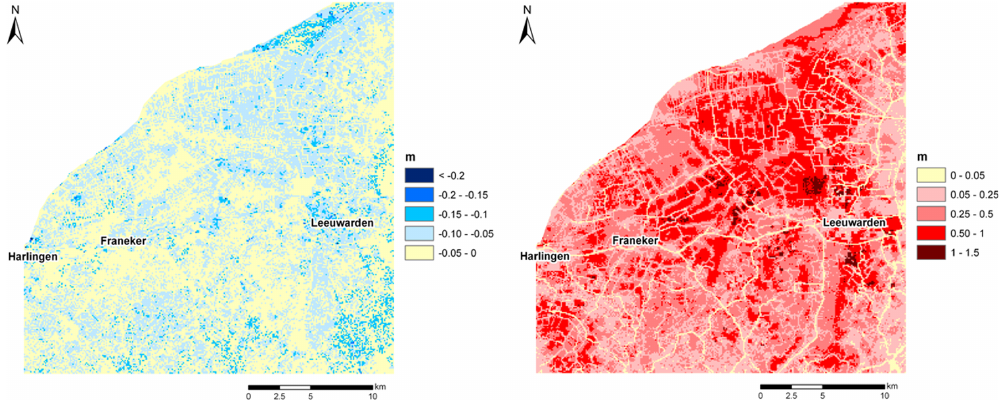
Fig. 21. Groundwater level rise in the winter in the climate scenario W+ compared to the autonomic scenario in 2100 (left panel), and groundwater level drop in the summer in the climate scenario W+ compared to the autonomic scenario in 2100 (right panel).